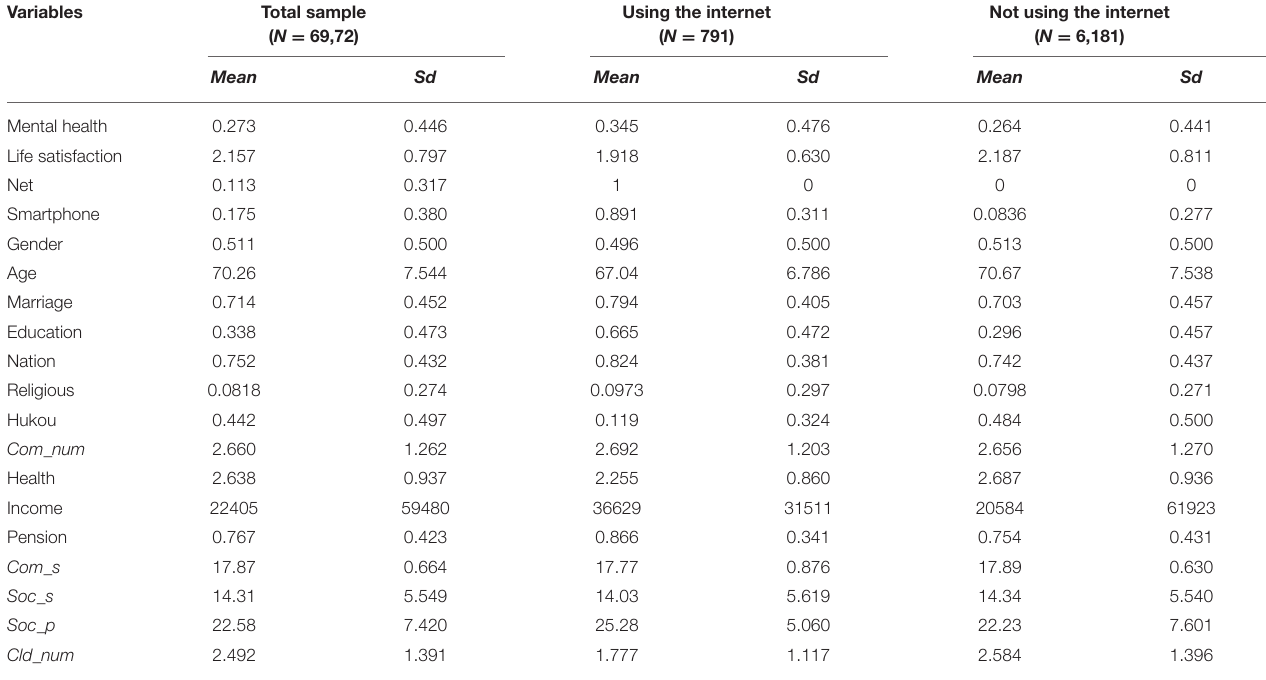
TABLE 2 | Descriptive statistics of the main